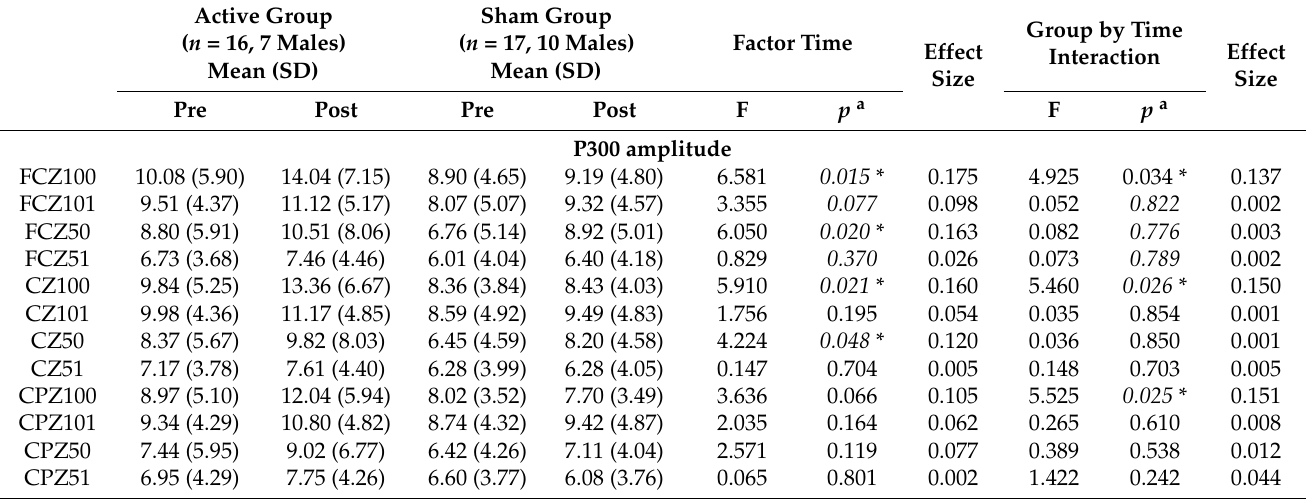
Table 2. Planned 2 × 2 repeated measure ANOVA on P300 amplitude over time (pre-tDCS,